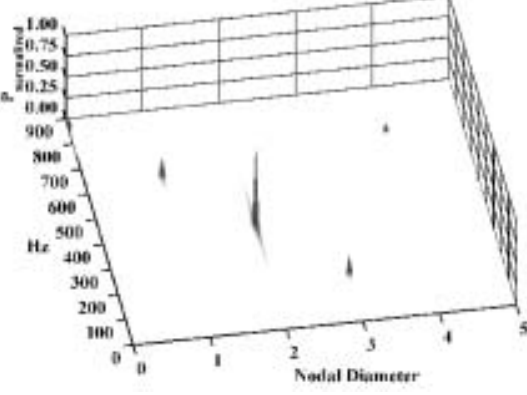
Fig. 18. Theoretical simulation of 2 nodal diameter flutter signal that includes the absence of two pressure